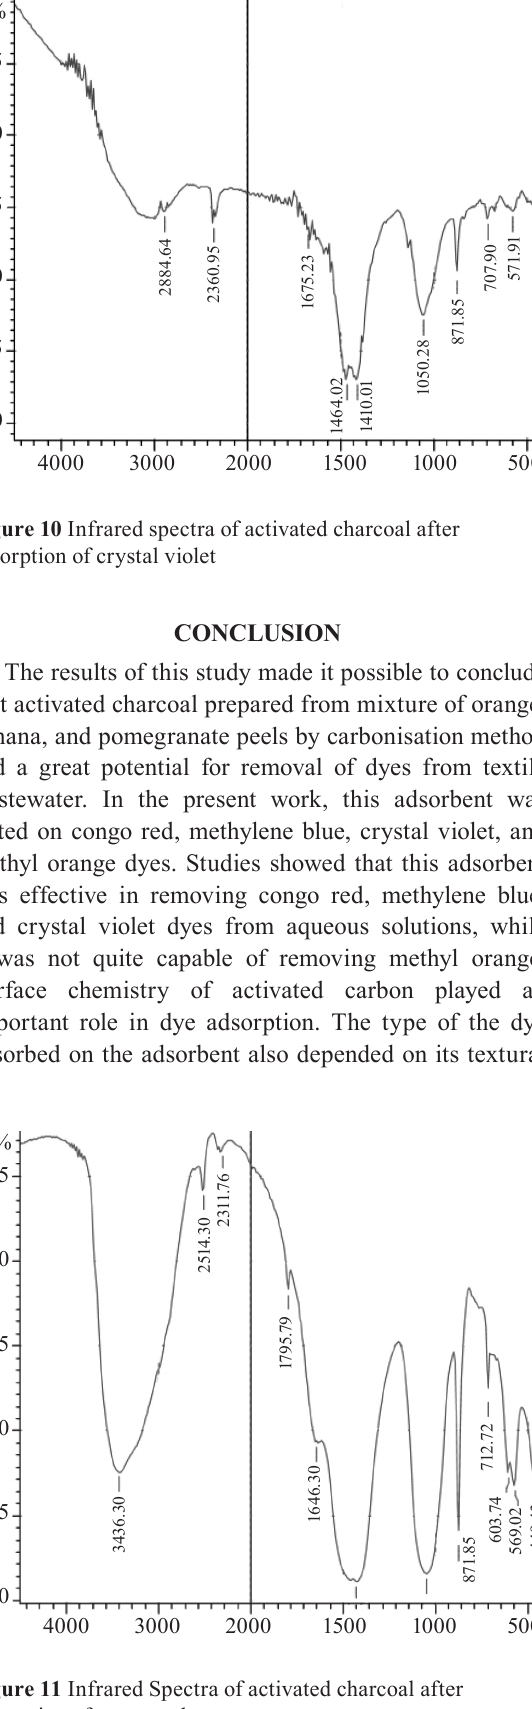
Figure 11 Infrared Spectra of activated charcoal after adsorption of congo red